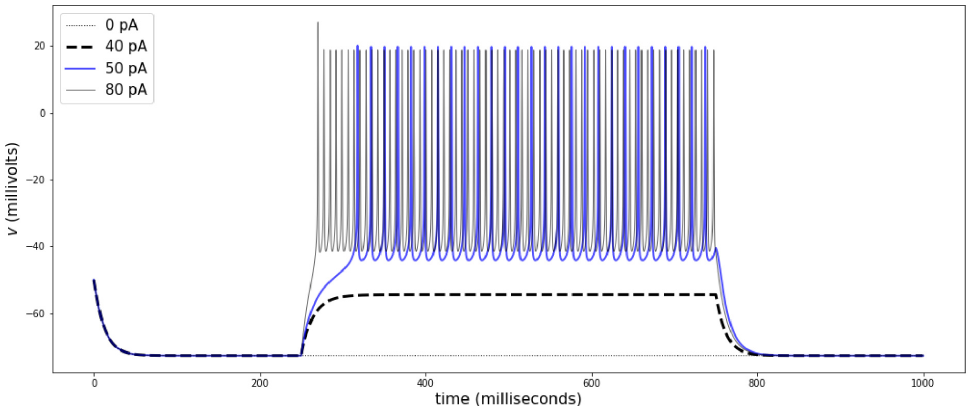
Figure 7. Rest to spiking transitions of FS interneuron under current clamp. The traces show responses to current-clamp stimulation of different amplitudes. The transition between rest and spiking with a rheobase occurs between 40 and 50 pA, as shown for some FS neurons in the mouse striatum (Orduz et al., 2013). The traces correspond to stimulation amplitudes of 0 (gray dots), 40 (black dashed line), 50 (blue), and 80 pA (gray). Parameters can be found in Table 4.